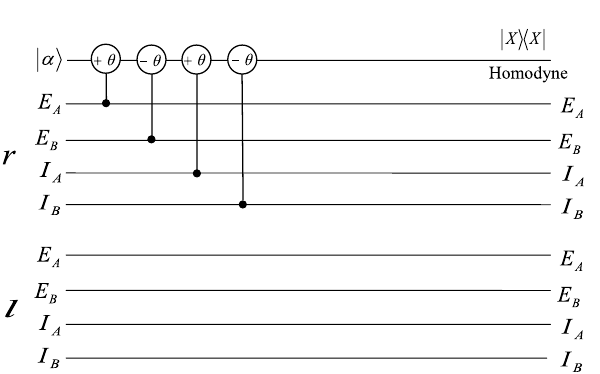
rr ll lr and from | � | � | �